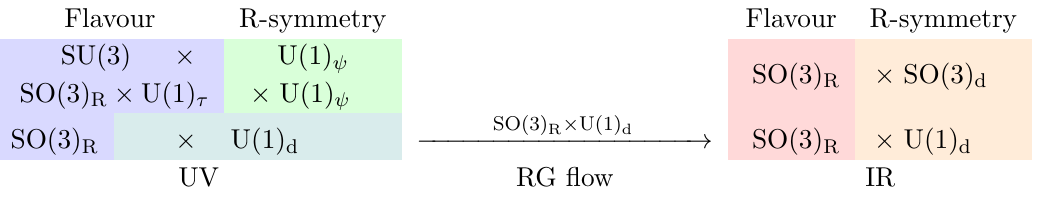
Table 4 . Summary of bosonic global symmetry groups involved in the GY (cid:13)ow. The top lines correspond to the full symmetry enjoyed by the (cid:12)xed points, with subsequent rows giving the explicit subgroups mentioned in the